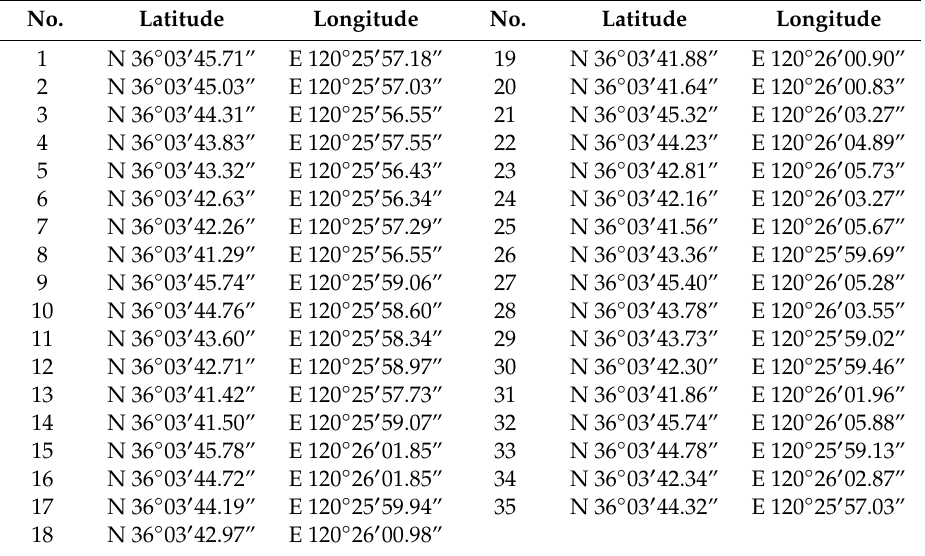
Table A1. Location coordinates of 35 planned points.